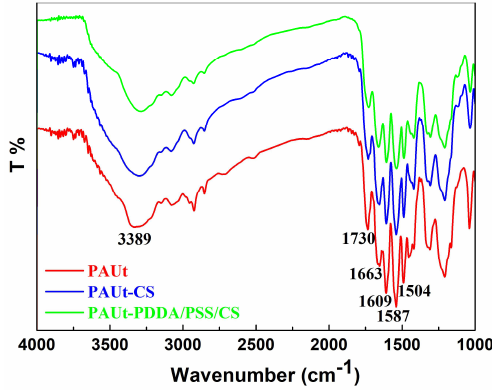
Figure 3. ATR-FTIR spectrum of PAUt, PAUt-CS, and PAUt-PDDA/PSS/CS membrane, respectively.